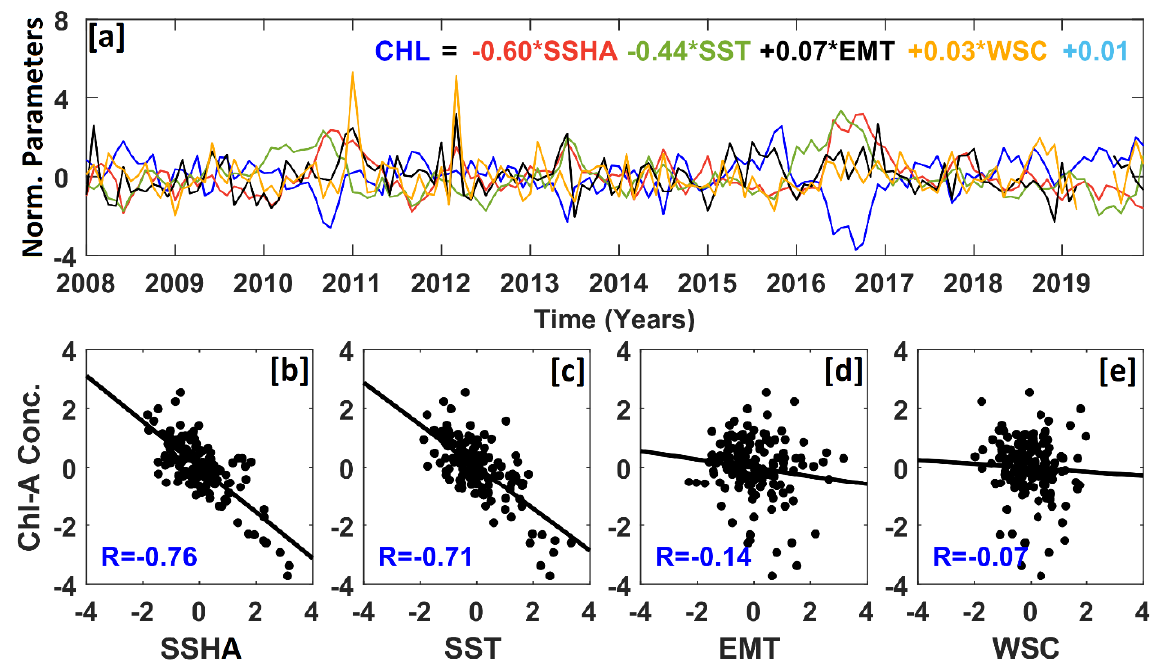
Figure 8. (a) Temporal variation of the climatology-removed, detrended and normalized time series of all the physical parameters during 2008–2019. The equation on the top right corner represents the multiple regression equation. Comparison of monthly chlorophyll-a concentration datasets with ( b ) sea surface height anomaly (SSHA), ( c ) sea surface temperature (SST), ( d ) Ekman mass transport (EMT) and ( e ) wind stress curl (WSC). The black line represents the best fit line.